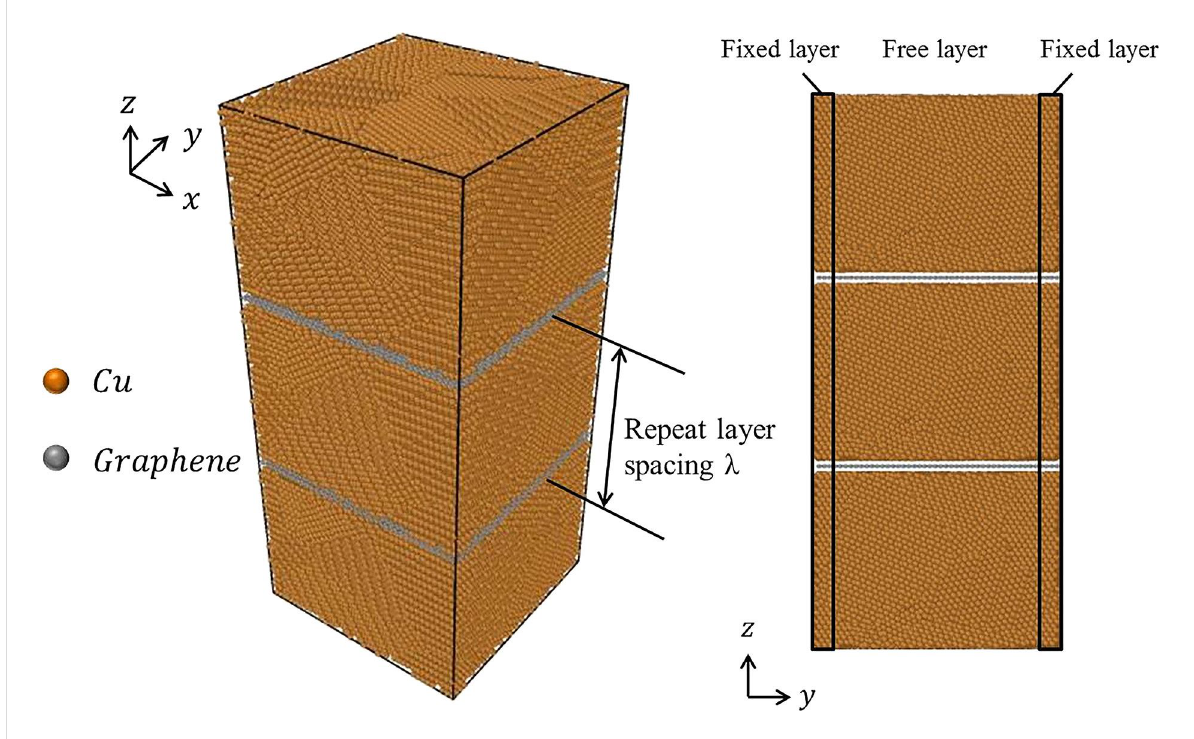
Figure 1: Schematic of GPCuNL composite.